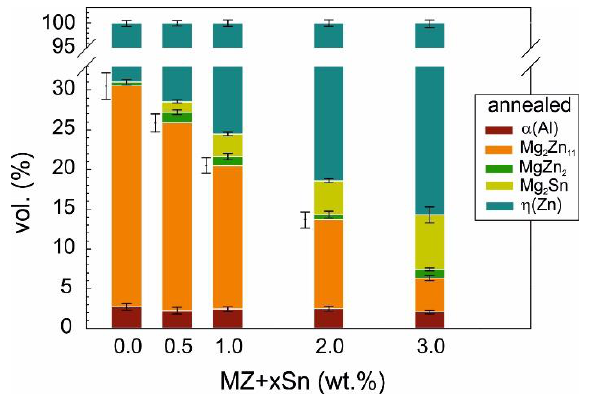
Figure 8. Phase fractions in vol.% in metallic bulk samples as measured on metallic filings of annealed samples.